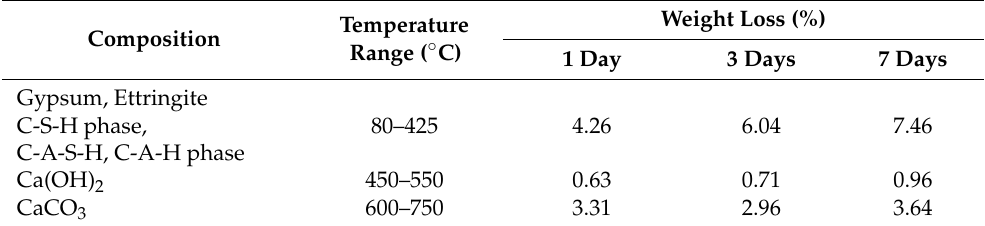
Figure 3. TGA heating curve of CFB fly ash-BFS-cement blended paste. Table 4. Calculated weight loss of paste at different ages.